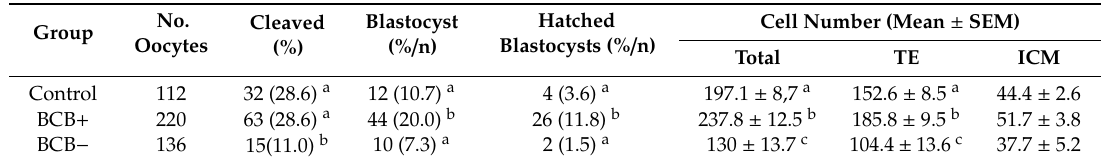
Table 2. Embryonic development after in vitro maturation and fertilization of domestic cat oocytes obtained from ovaries of anestrus cats by Brilliant Cresyl Blue (BCB) staining.